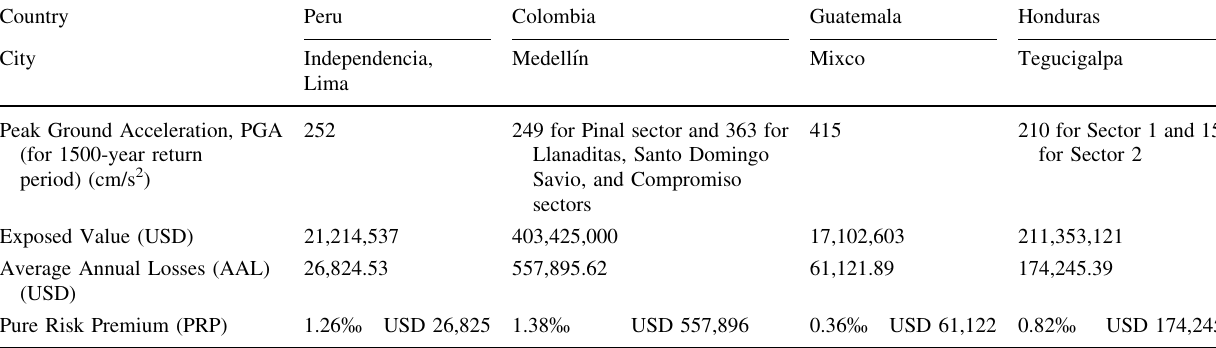
Table 4 Catastrophe risk assessment and pure risk premium costs—seismic events. Source : Adapted from Cardona (2018a) Country